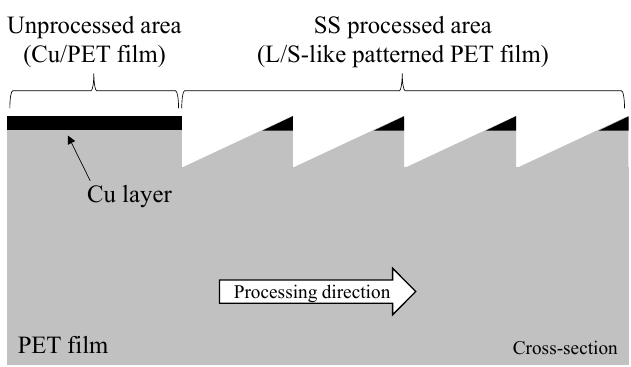
Figure 8. Schematic of the ideal line and space (L / S)-like pattern of the SS-processed Cu / PET film.